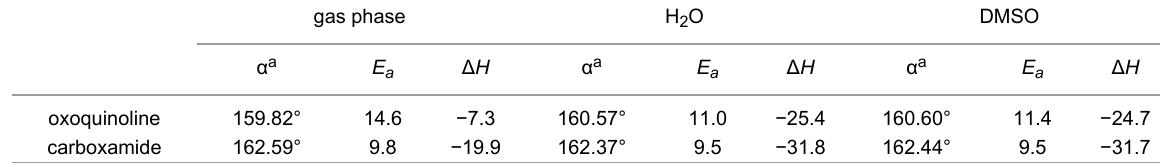
Table 3: Activation energies and enthalpies of both oxoquinoline and carboxamide N-ethylation reaction in different media (kcal·mol − 1